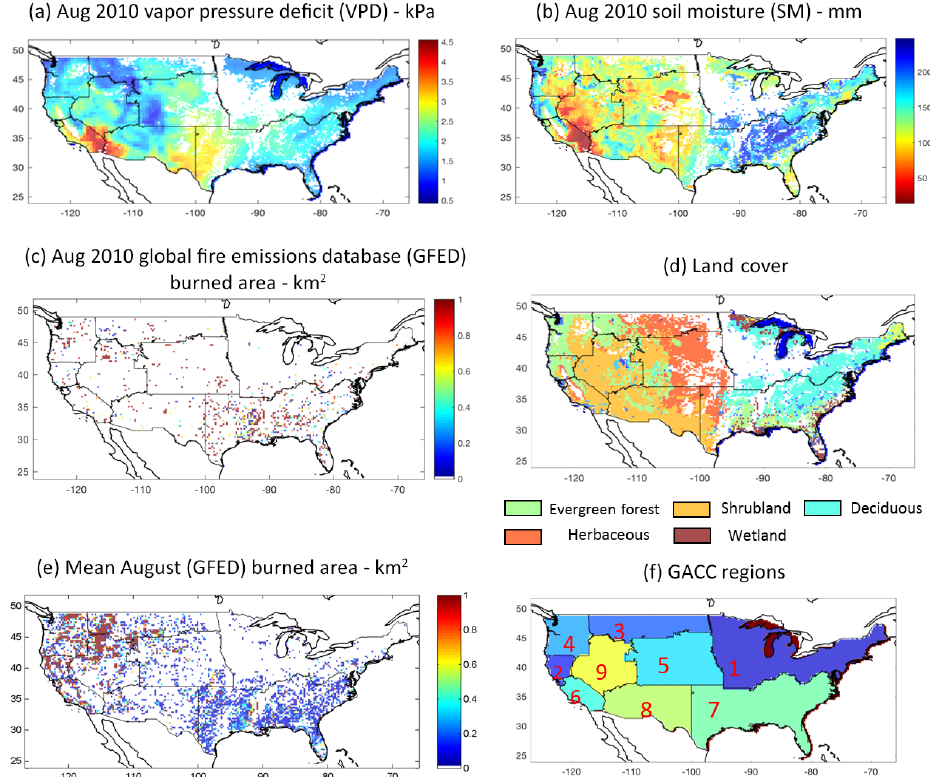
Figure 1. Snapshot of August 2010 of the datasets used in relation to the geographic area coordination centers (GACCs). Panel (e) shows the long-term mean of August GFED burned area. GACC regions are (1) Eastern, (2) Northern California (CA), (3) Northern Rockies, (4) Northwest, (5) Rocky Mountain, (6) Southern CA, (7) Southern, (8) Southwest and (9) Great